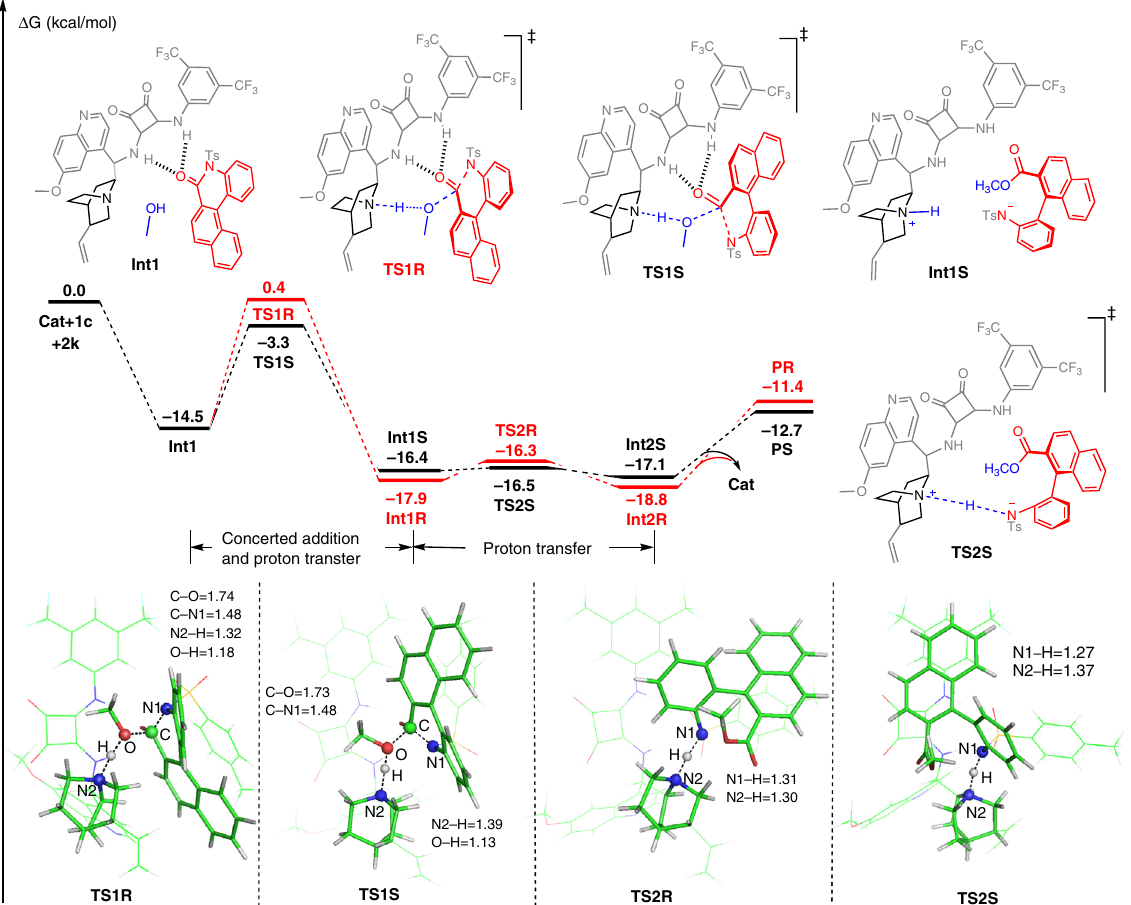
Fig. 3 Reaction energy pro fi le. Stereoselective reaction pathways calaulated at the M06-2X-GD3/6-311 ++ G(2d, 2p)/IEF-PCM o-xylene //M06-2X/6-31G (d, p)/IEF-PCM o-xylene